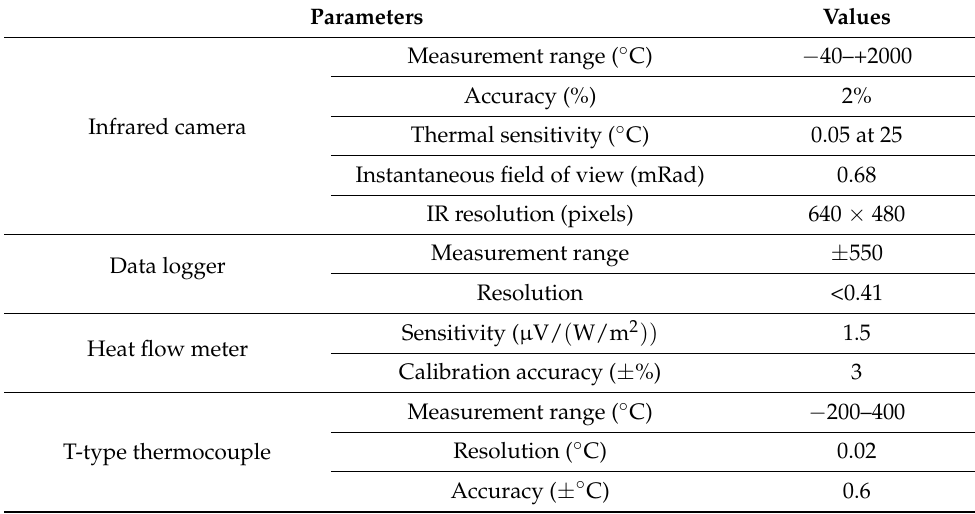
Figure 2. Test chamber device for the Korean Standard (KS F 2278). ( a ) Front view of the test chamber; ( b ) Plan view of the device. Table 1. Equipment specifications.